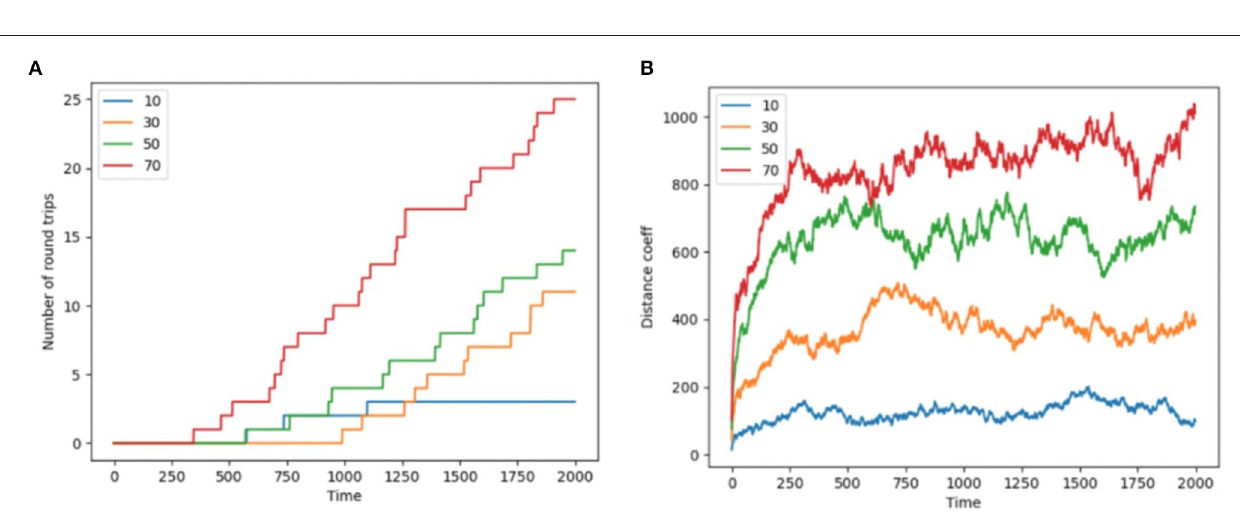
on round trips appears to be non-linear in that the colonies of different size are not simply scalings of one another. However we we did not explore variation in critical model parameters such